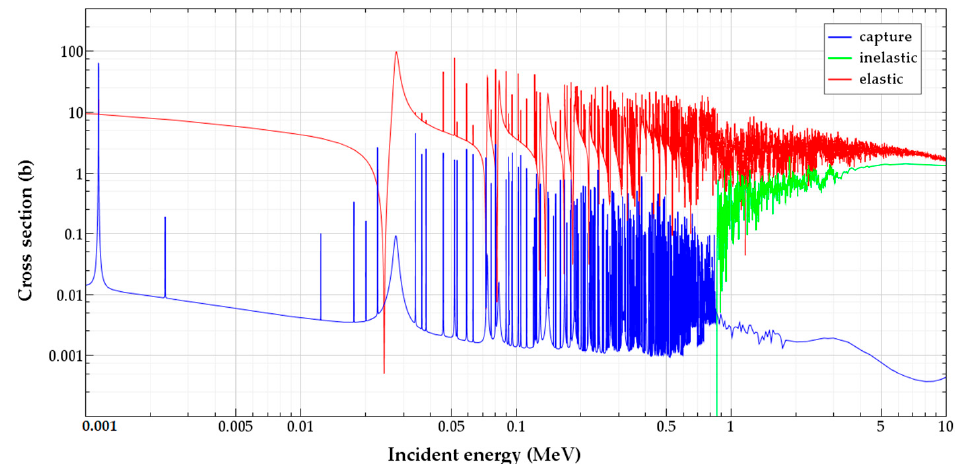
Figure 1. Radiation capture cross section (blue line), inelastic cross section (green line), and elastic cross section (red line) of Fe-56 in energy range of 1.0 keV to 10.0 MeV (CENDL-3.2).